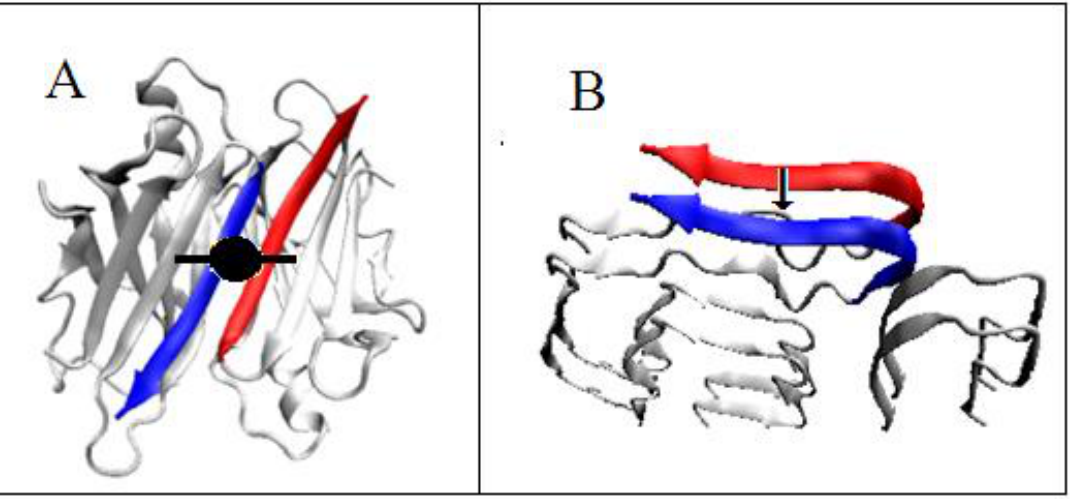
Figure 9. The structure of transthyretin. ( A )—native homo-dimer—the double axis expressing operation of symmetry marked. ( B )—two chains in the amyloid form—the arrow shows the translation operations. The sections responsible for dimer stabilization by creating a β sheet propagating through both monomeric units in an anti-parallel form are marked. The same fragments in the amyloid system represent the β -structure system in parallel form.